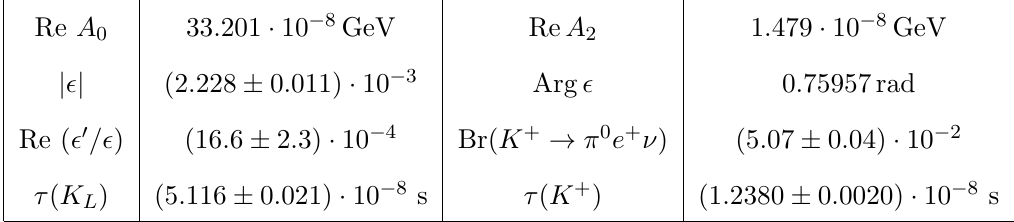
Table 10 . Experimental input for the (cid:1) S = 1 processes (cid:15) 0 =(cid:15) and K L ! (cid:25) 0 e + e (cid:0) [71].